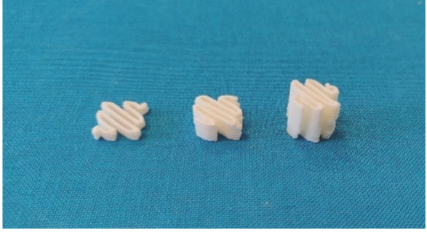
Figure 11. Photo of the three printed oral forms (from left to right, 51 mm, 100 mm and filaments). 200 mm